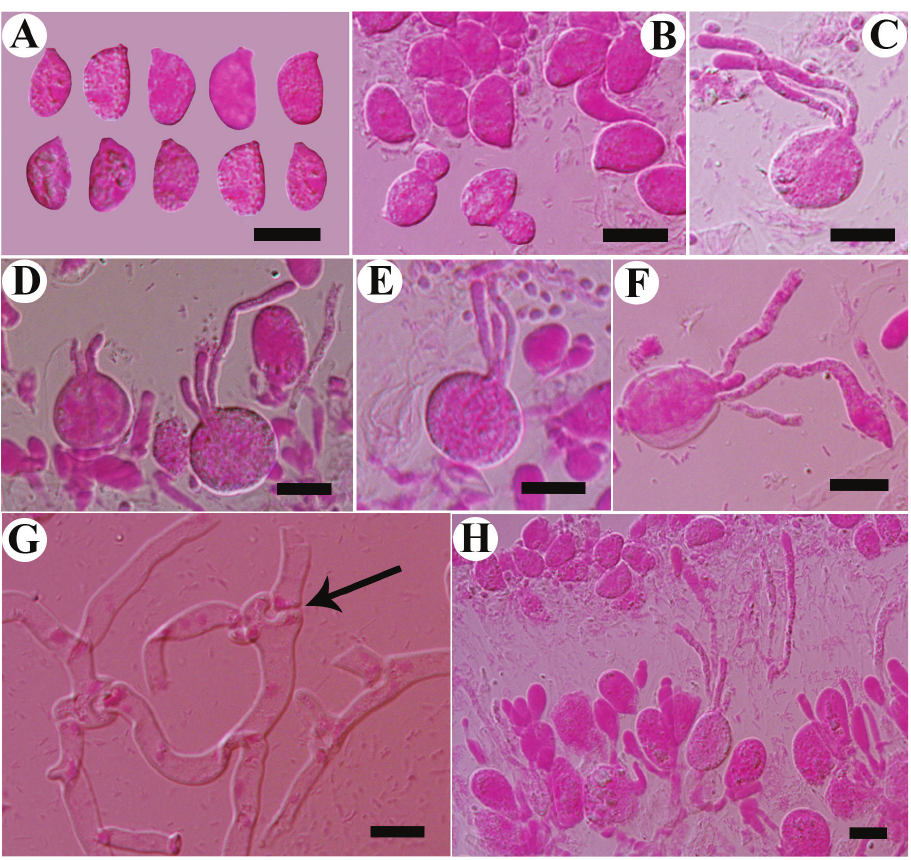
Figure 4. Microscopic structures of Tremella fibulifera s.s. (SP 211759) A basidiospores B germination tubes of basidiospores and secondary spores C–F basidia at different stages G hyphae with clamp connec- tions and clamp complexes; H a section of hymenium. Scale bars: 10 µm ( A–H